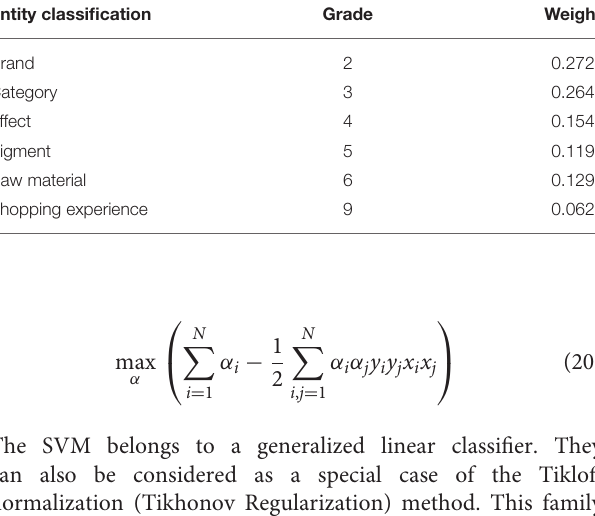
TABLE 5 | Final weight system of cosmetics category. Entity